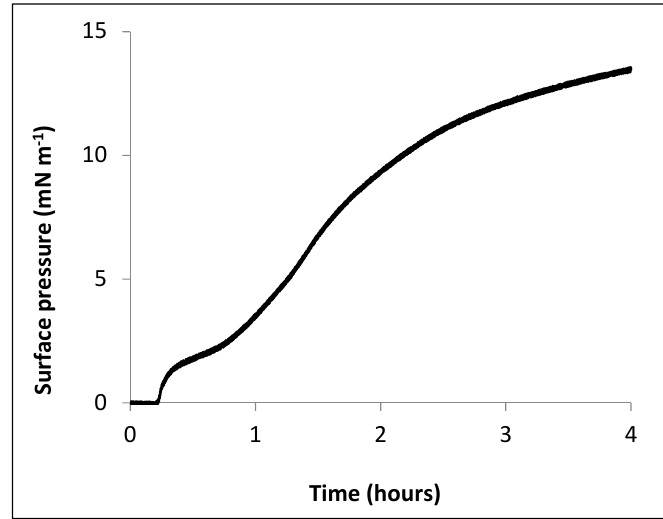
Figure 1. Adsorption isotherm of CLIC1 to an air–water interface at 25 ˝ C and final concentration of 2 µ g ¨ mL ´ 1 (number of experiments, n =